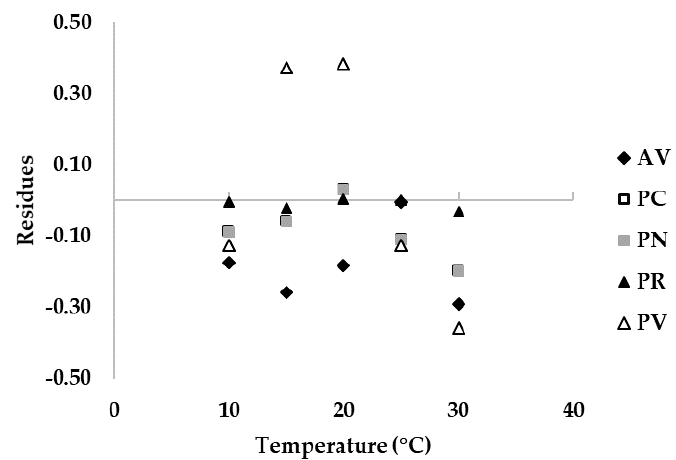
Figure 5. Plot of residuals between fungal relative growth on cheese rind and the fitting functions based on relative growth data obtained on Czapeck Yeast Agar, calculated for Aspergillus versicolor (AV), Penicillium crustosum (PC), P. nordicum (PN), P. roqueforti (PR), and P. verrucosum (PV) at different incubation temperatures (0–40 °C, step 5 °C).